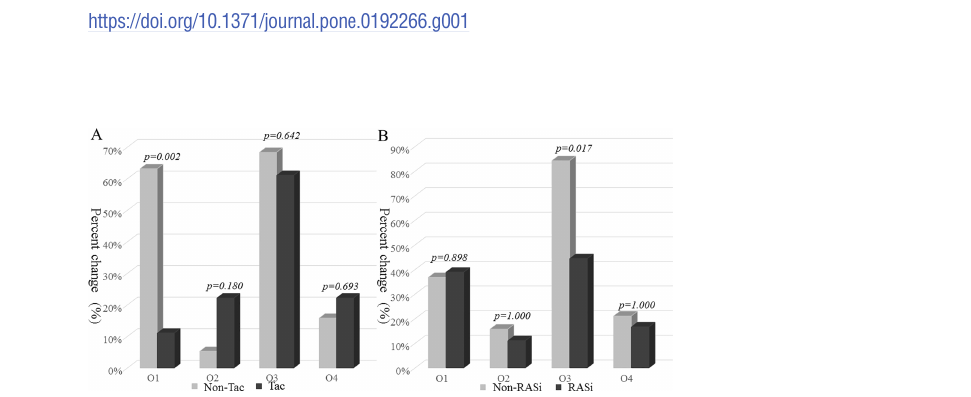
Fig 3. The difference in outcome parameters between groups. Outcome parameters represent the followings; O1, decrease of time-averaged proteinuria from trial phase and to the observational phase; O2, remission of UPCR < 0.2 g/ g cr during observational phase; O3, rapid decline of eGFR (cid:21) 5 mL/min/1.73 m 2 during observational phase; O4, composite outcome of increase in serum cr level ( (cid:21) 50% from baseline) noted during observational phase or deterioration of renal function to end stage renal disease. Outcome parameters were compared by Chi-square test or Fisher’s exact test according to the number of each cell in the tacrolimus group (A) and RASi group (B).